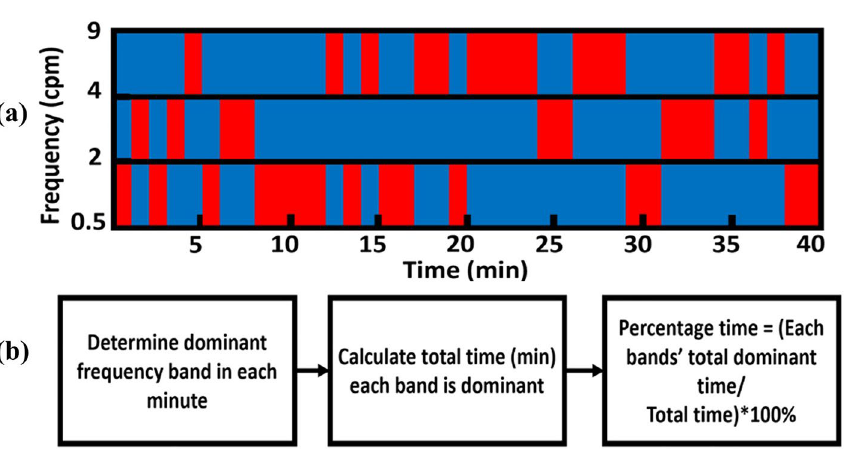
Figure 8. Dominant frequency band partition. ( a ) An example of minute-dependent dominant frequency band partition map across a time period (0–40 min). X-axis denotes the time in minutes; Y-axis represents three EGG rhythm frequency bands in cycles per minute (cpm). Red boxes indicate the dominant frequency band for each minute. ( b ) A flow chart of the procedure to calculate the % time spent in each GR band for each chosen time